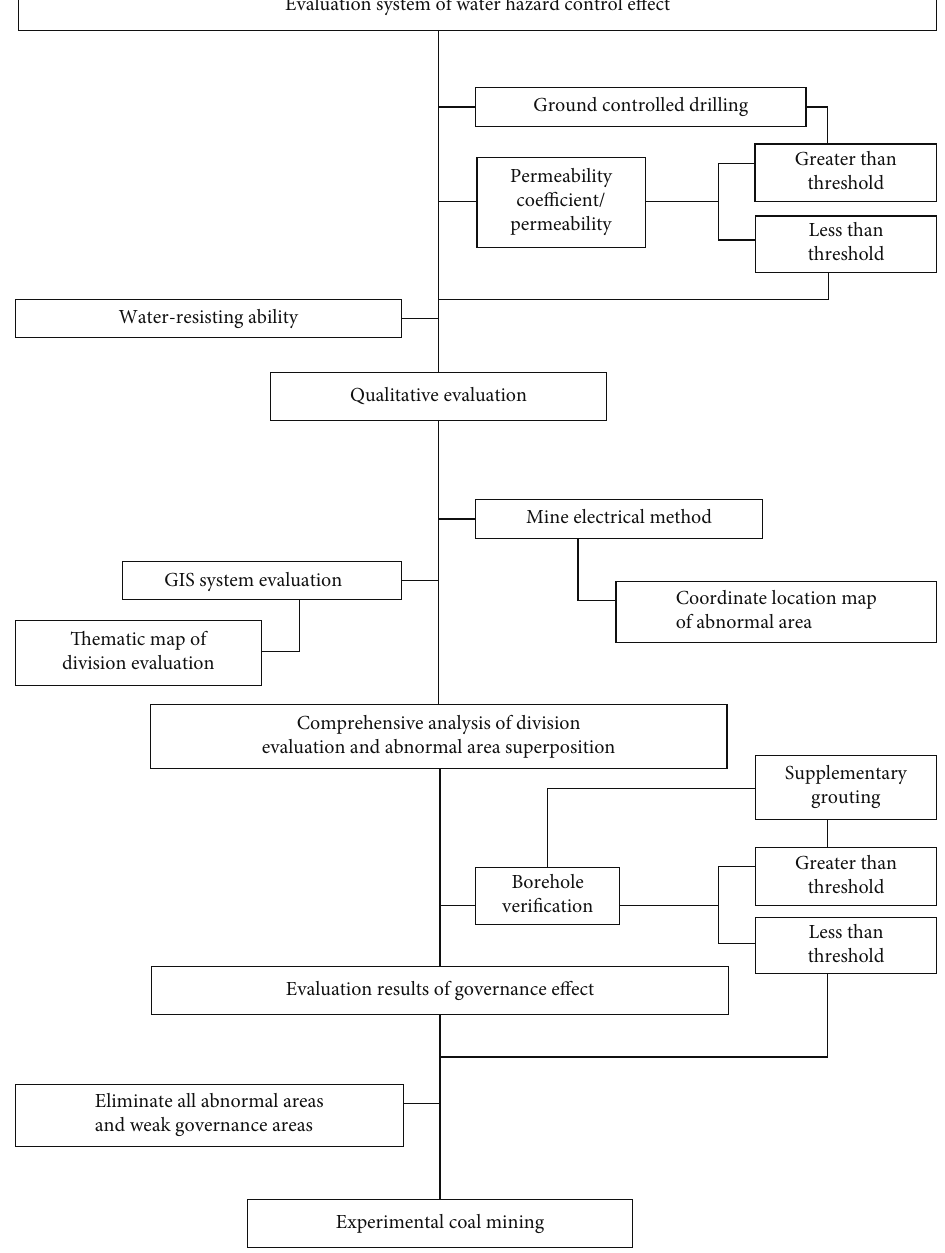
Figure 4: Flow chart of the “ SVE ” system for water hazard control e ff ect of deep coal seam fl